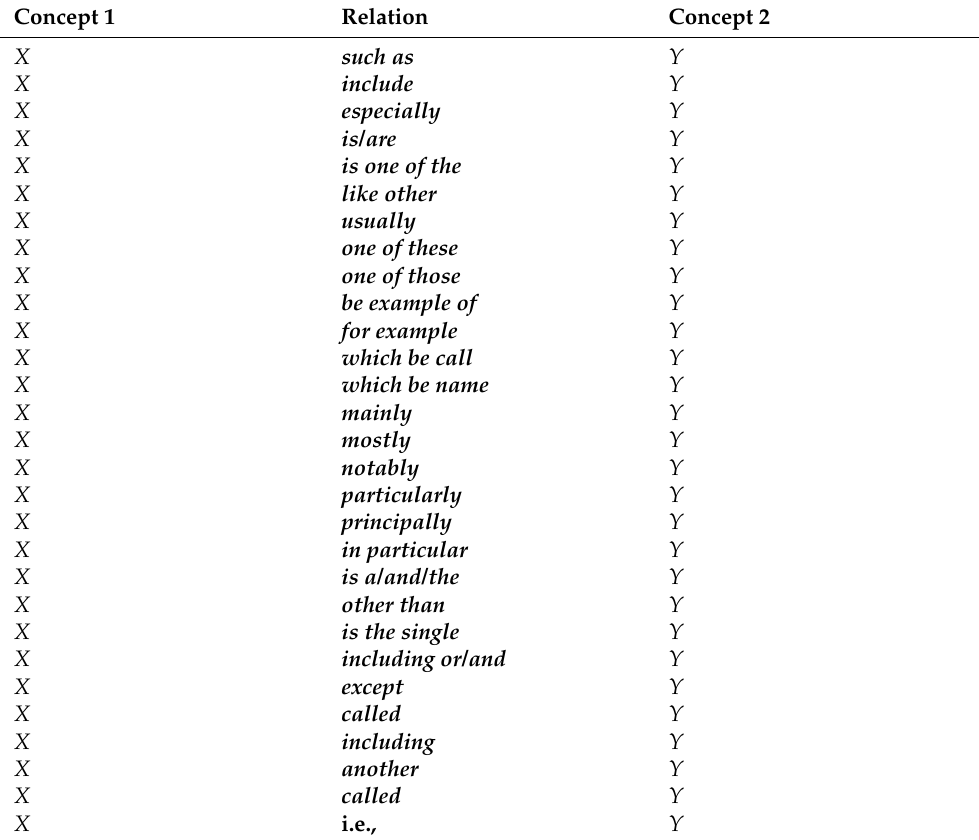
Table 2. Lexical-syntactic patterns to extract hyponymy and hyperonymy relationships.